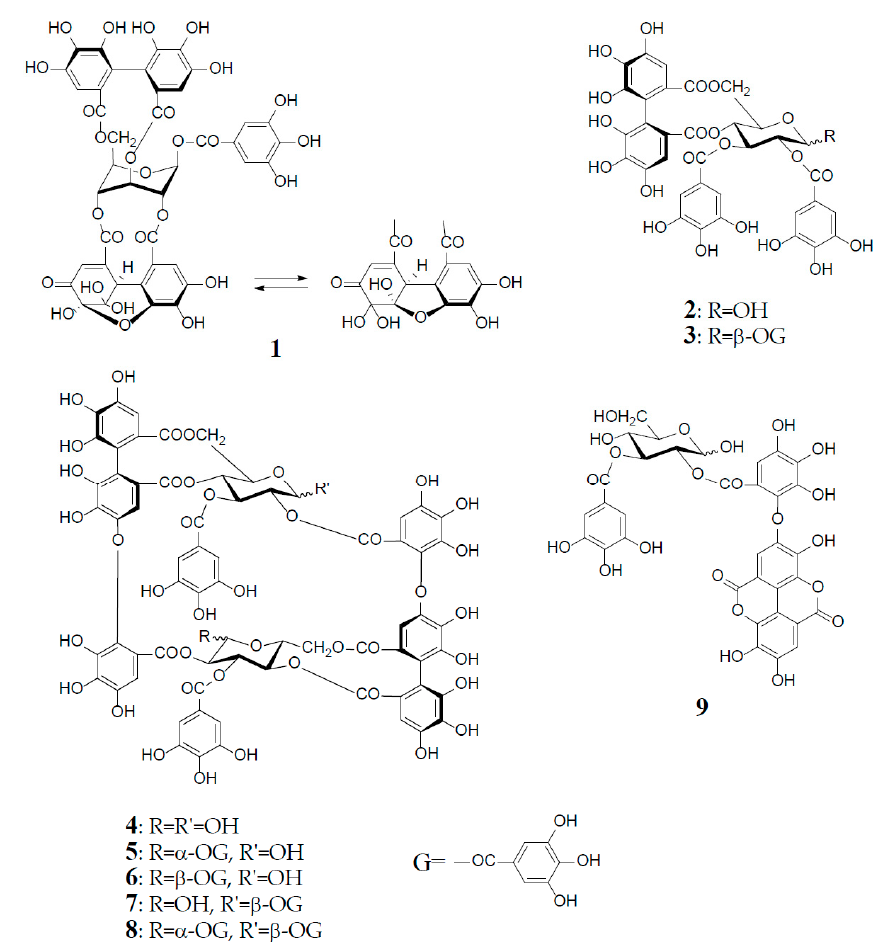
Figure 1. Structures of geraniin ( 1 ), tellimagrandin I ( 2 ), and II ( 3 ), oenothein B ( 4 ), woodfordin C ( 5 ), eugeniflorin D 1 ( 6 ), cuphiin D 2 ( 7 ), cuphiin D 1 ( 8 ), and oenothein C ( 9 ).